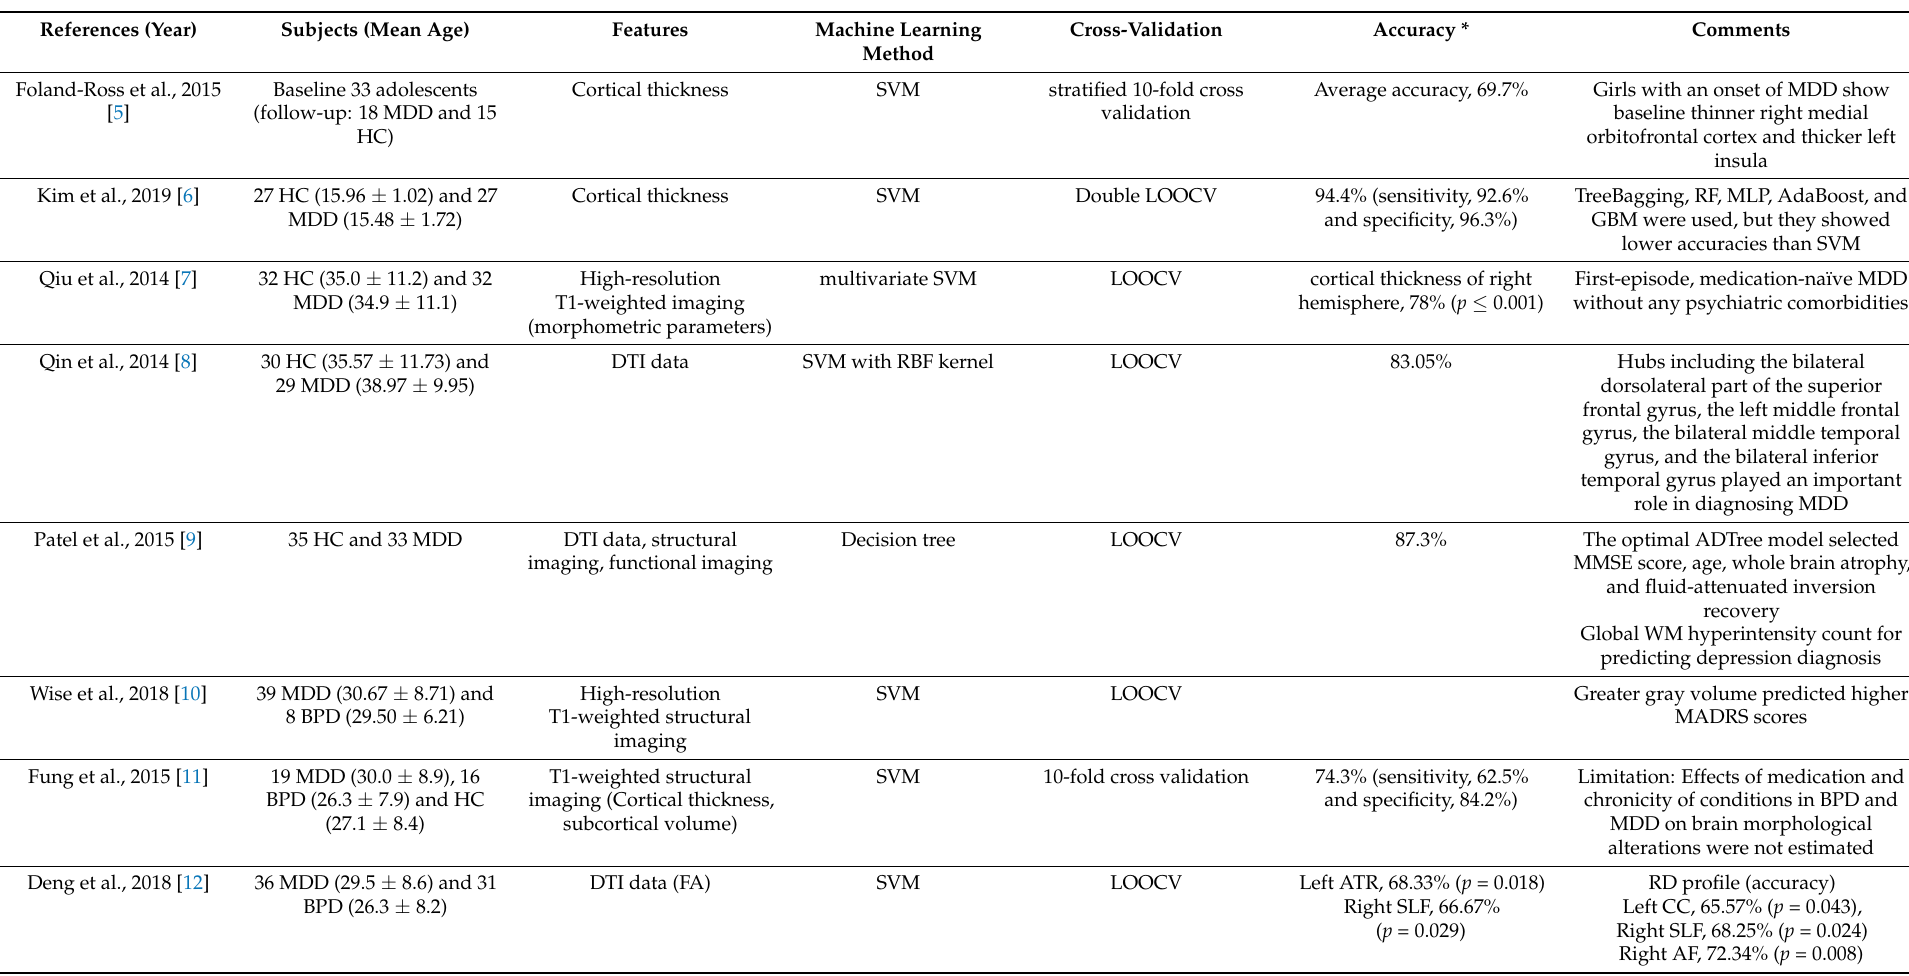
Table 1. Selection of studies investigating machine learning methods for the prediction of diagnosis in